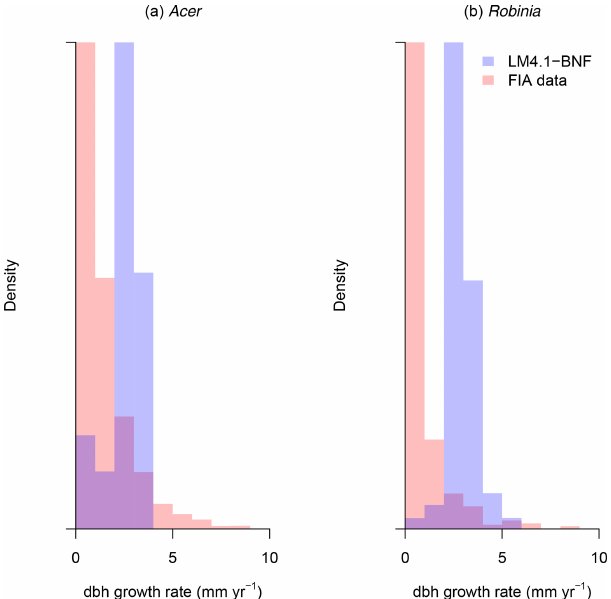
Figure D1. Simulated dbh growth rate for (a) Acer /non-fixer and (b) Robinia compared to FIA data (in North Carolina). Simulated data are trees with dbh > 12 . 7cm to reflect the dbh range of FIA data and are weighted by the stand age distribution of FIA data (Fig. D18). Simulated and FIA data are scaled to display an equal maximum density. LM3-SNAP cannot distinguish between plant cohorts with different dbh’s or distinguish between Robinia and Acer .